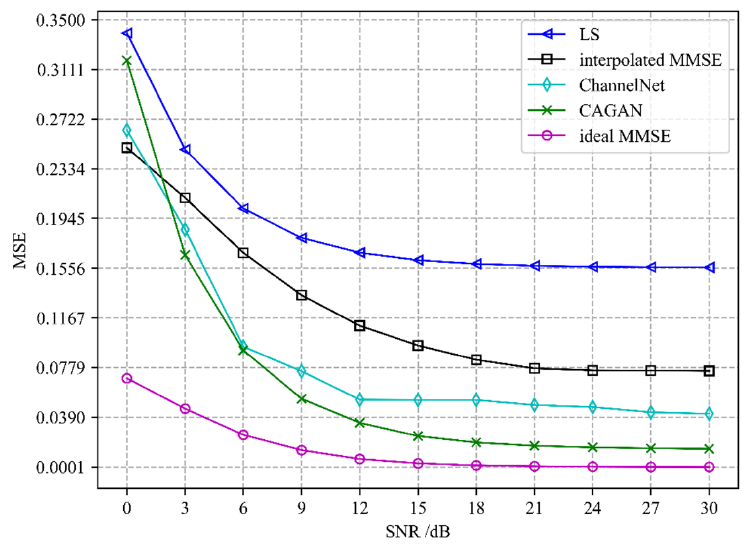
Figure 5. Performance comparison of different algorithms when the number of pilots is 8.